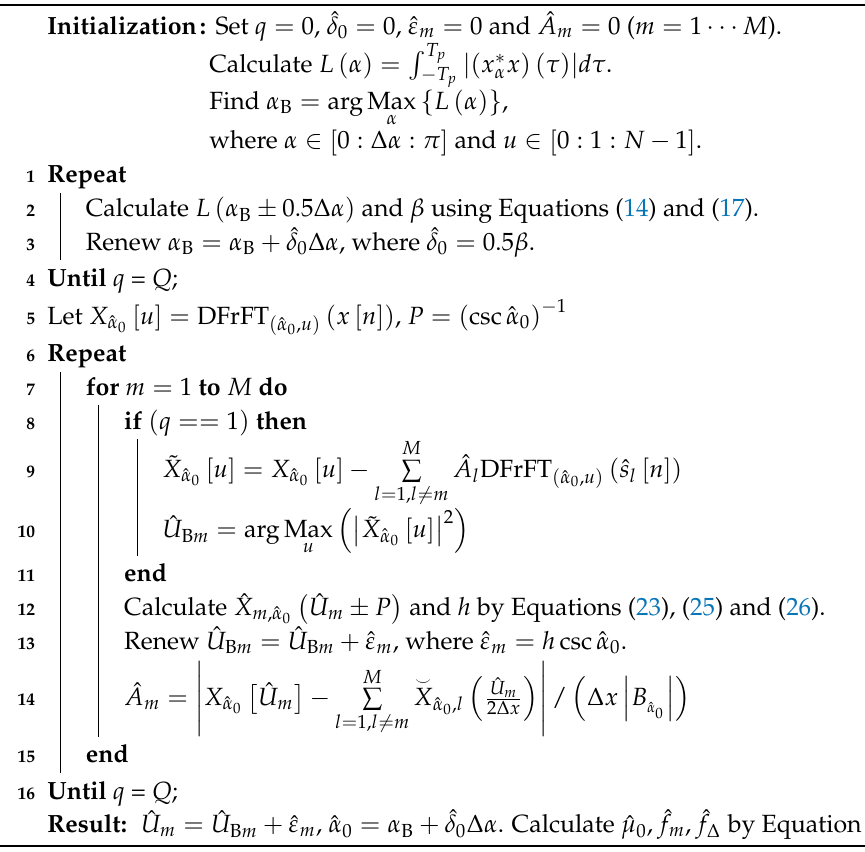
Algorithm 1: Proposed fast iterative interpolated digital fractional Fourier transform